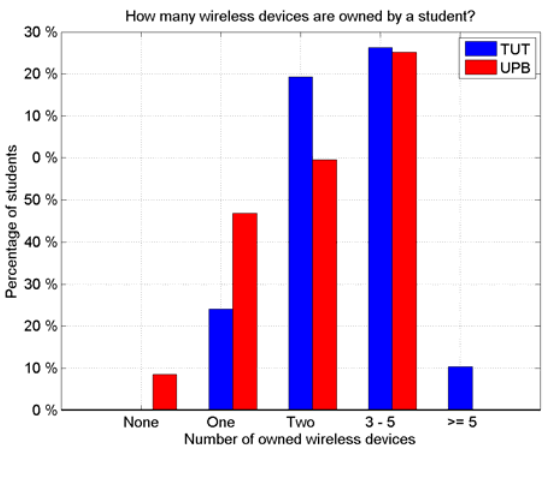
Figure 4. Number of wireless devices owned by the